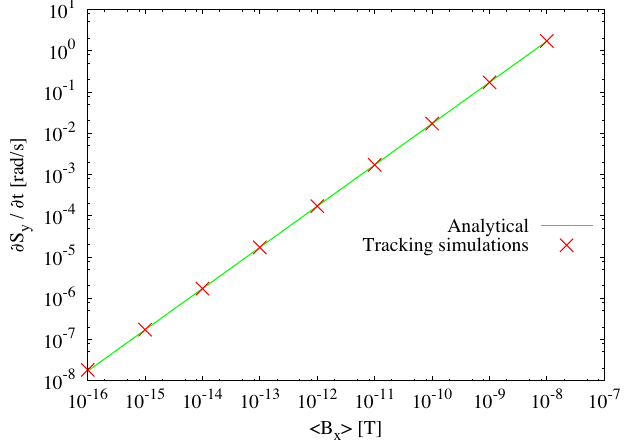
FIG. 3. Vertical spin buildup as a function of the average residual radial magnetic field on the closed orbit and comparison with the analytical estimate given by Eq. (31).